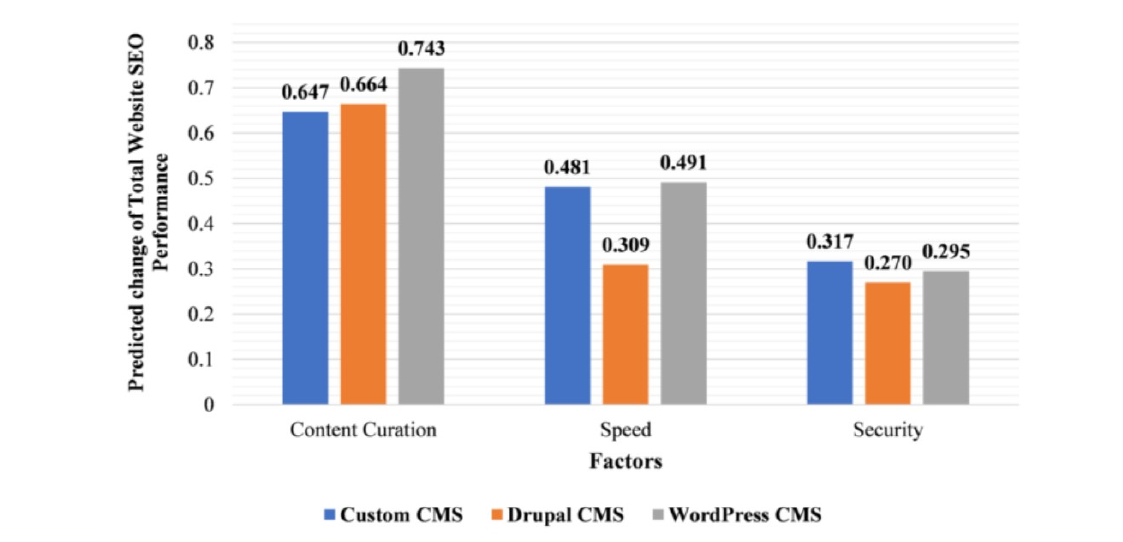
Figure 3. Comparison among the factors and their potential predicted change to Total Website SEO